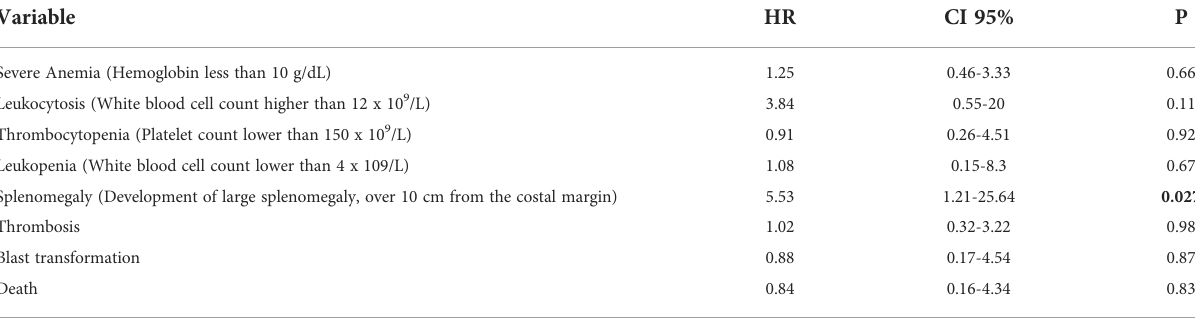
TABLE 3 Univariate Cox regression analysis of EDA-FN plasma levels with clinical endpoints in PMF patients with elevated EDA-FN group as compared to EDA-FN normal group. HR = Hazard Ratio, P = p value. Variable